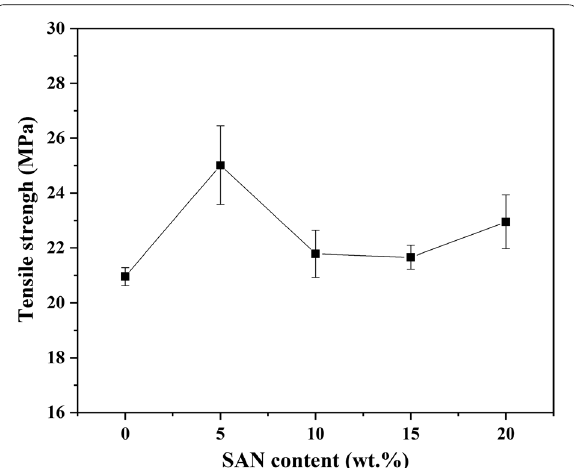
Fig. 7 VST values of PP and SAN/PP blends